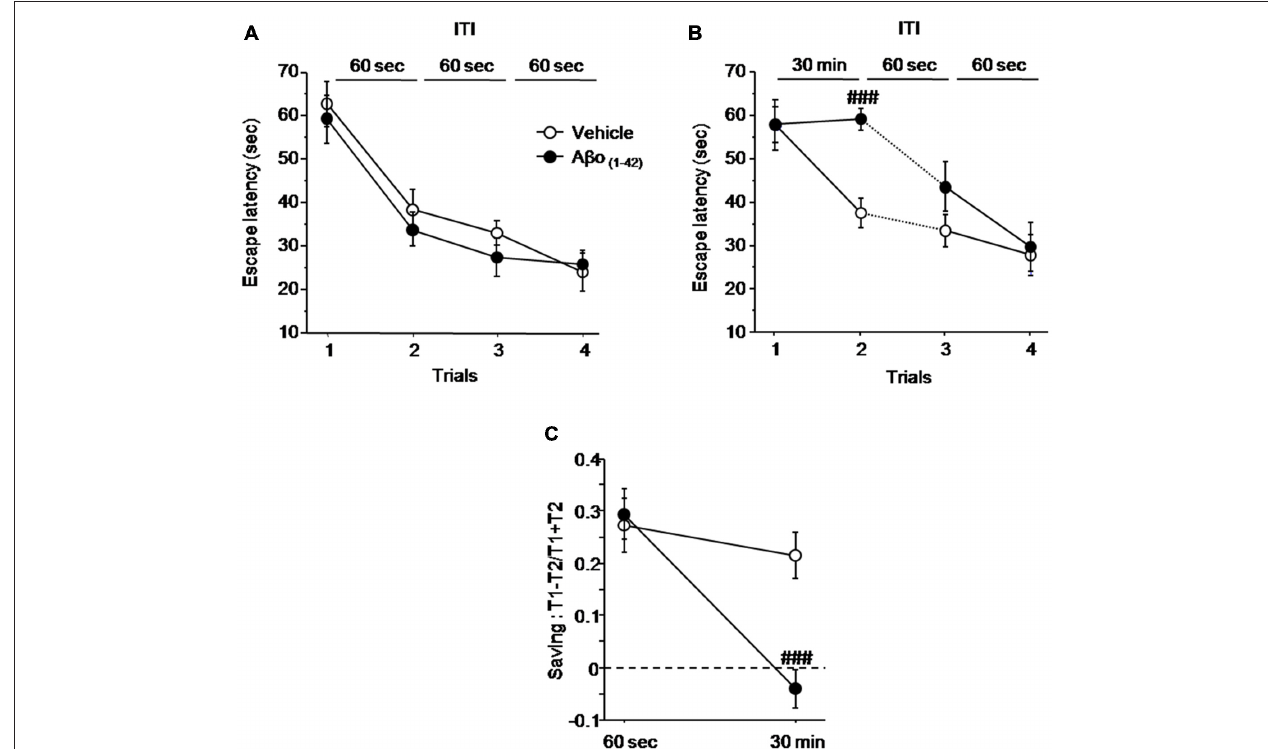
FIGURE 4 | Intra-dCA1 A β o ( 1 – 42 ) treatment decreases working memory performance in a delayed matching to place paradigm in the water maze . Escape latencies (sec) as well as percentage saving were measured in A β o ( 1–42 ) ( n = 8) and vehicle ( n = 9) groups. (A) A β o ( 1–42 ) and Vehicle groups showed similar escape latency values during the four trials when the ITI was fixed at 60 s. (B) A β o ( 1–42 ) group exhibited a reduced escape latency value between trial 1 and trial 2 when ITI was set at 30 min, which was restored to that of vehicle group when ITI was reduced to 60 s. (C) A β o ( 1–42 ) group exhibited a decrease in percentage of saving when ITI was 30 min compared to vehicle group whereas no saving difference was observed when ITI was 60 s. Saving was expressed as (Latency trial 1–Latency Trial 2)/(Latency trial 1 + Latency Trial 2). Between-group comparisons : ### p < 0.001.